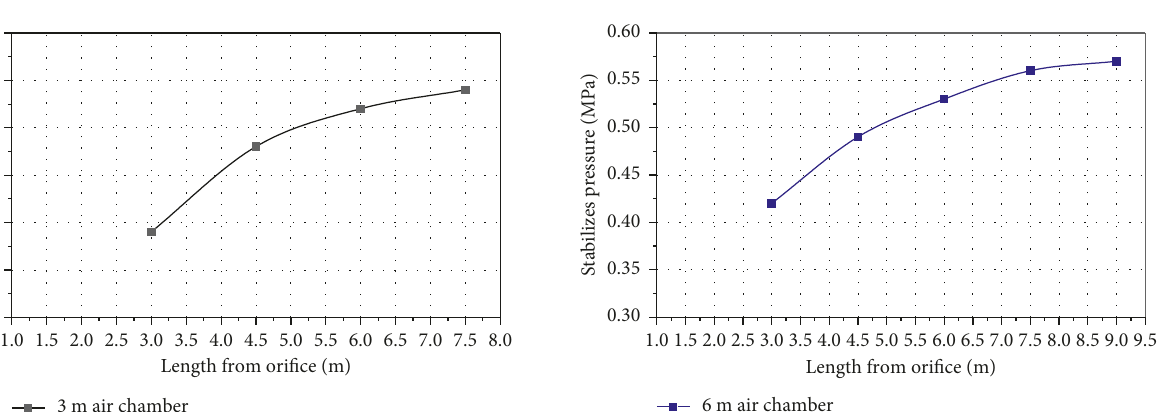
Figure 7: Stable pressure change in the 3-meter gas chamber.